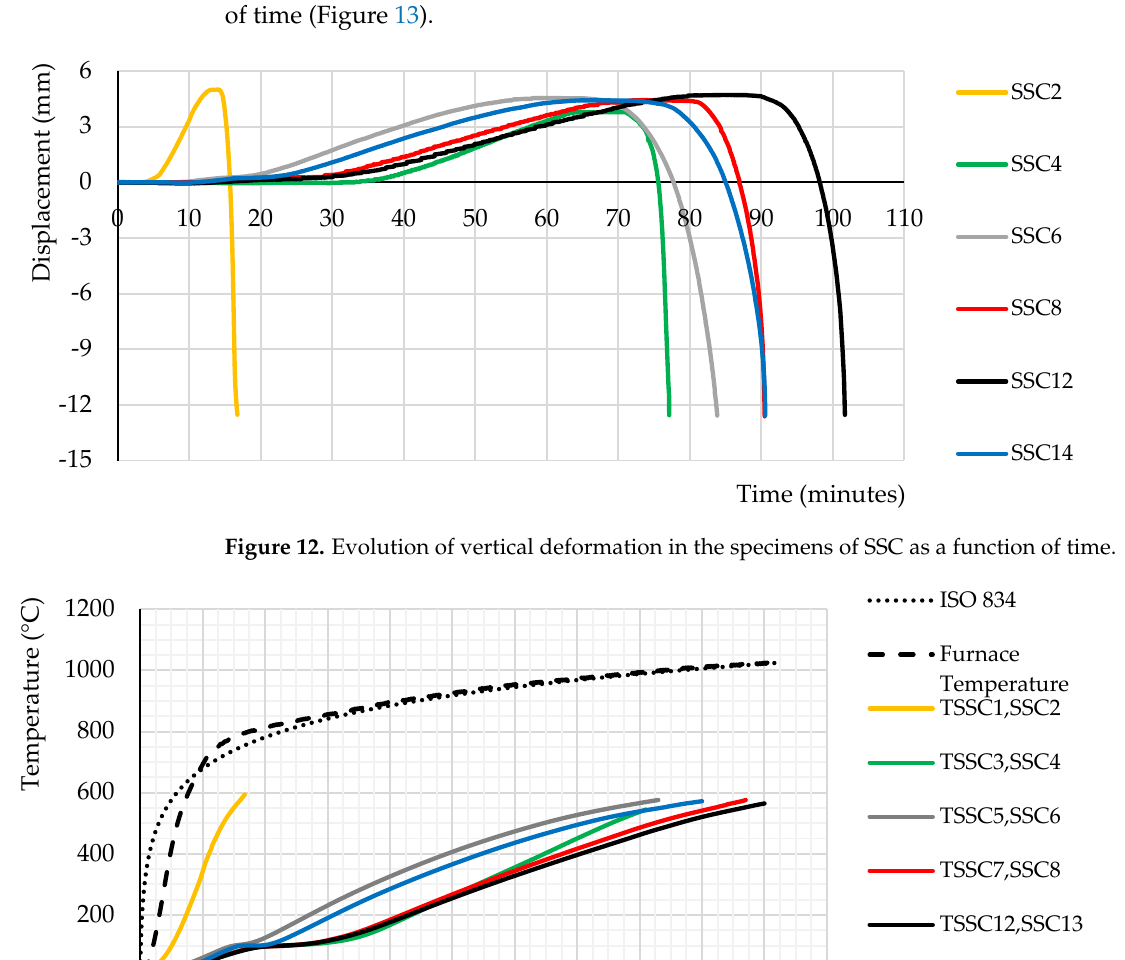
Figure 14. Photos of the specimens of SSC before and after tested, as an example.